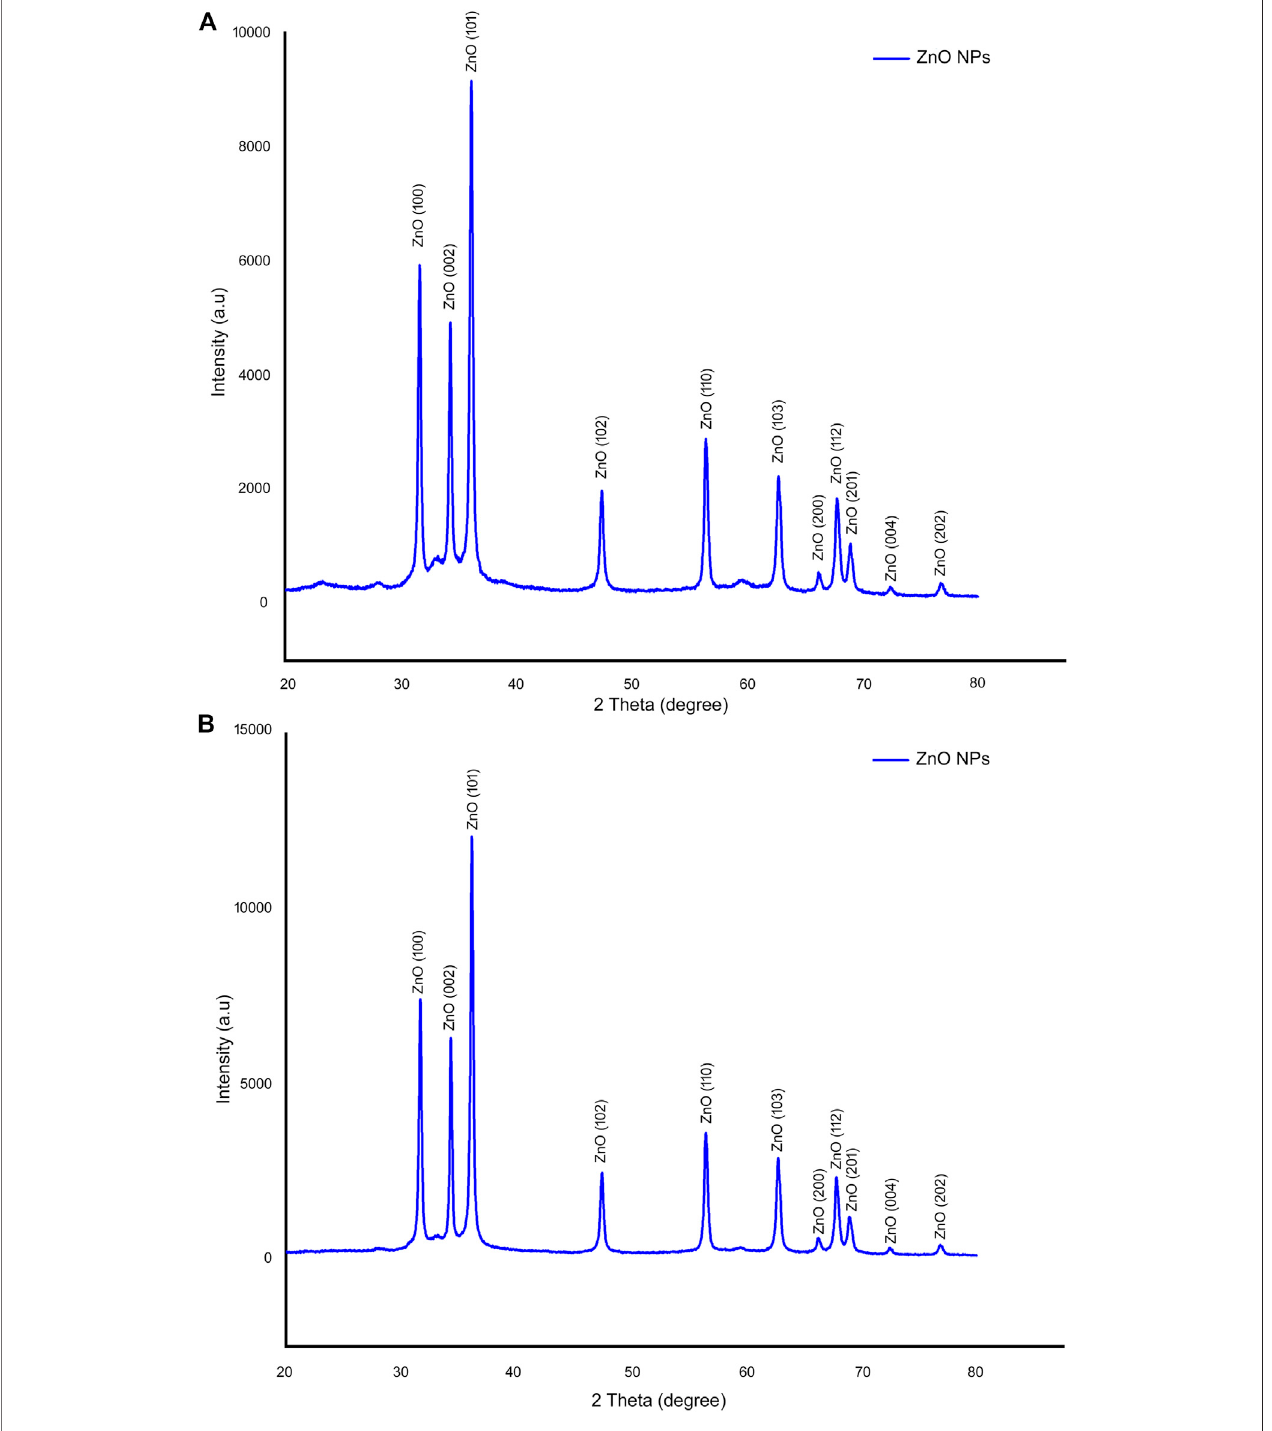
FIGURE 4 | X-ray diffraction (XRD) analysis of biogenic ZnO-NPs. (A) Ethanol extract of S. chirayita leaves and (B) methanol extract of S. chirayita leaves. Analysis was done using Origin software.